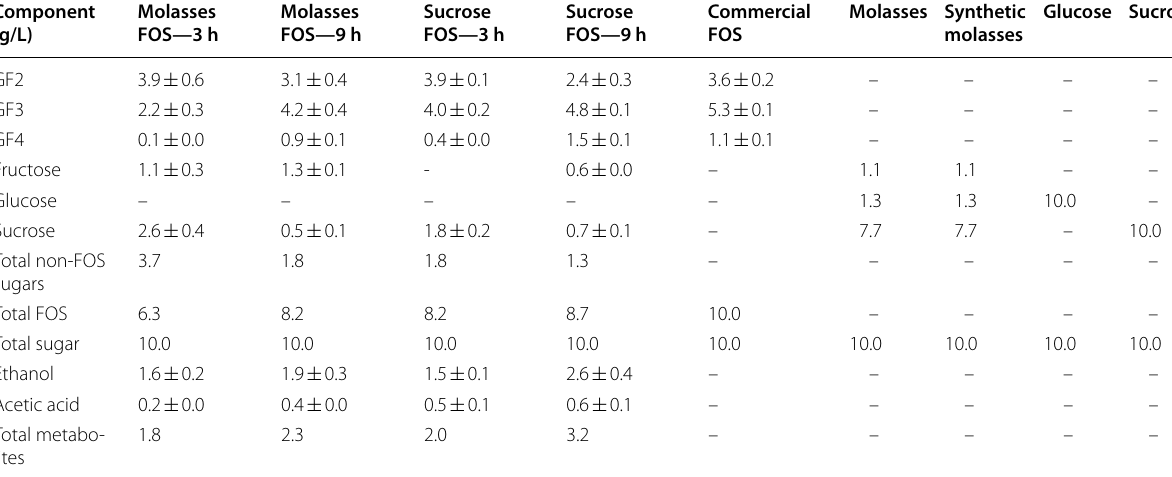
Table 2 Compositions of FOS sugars and non-FOS sugars for in vitro prebiotic activity assay Component